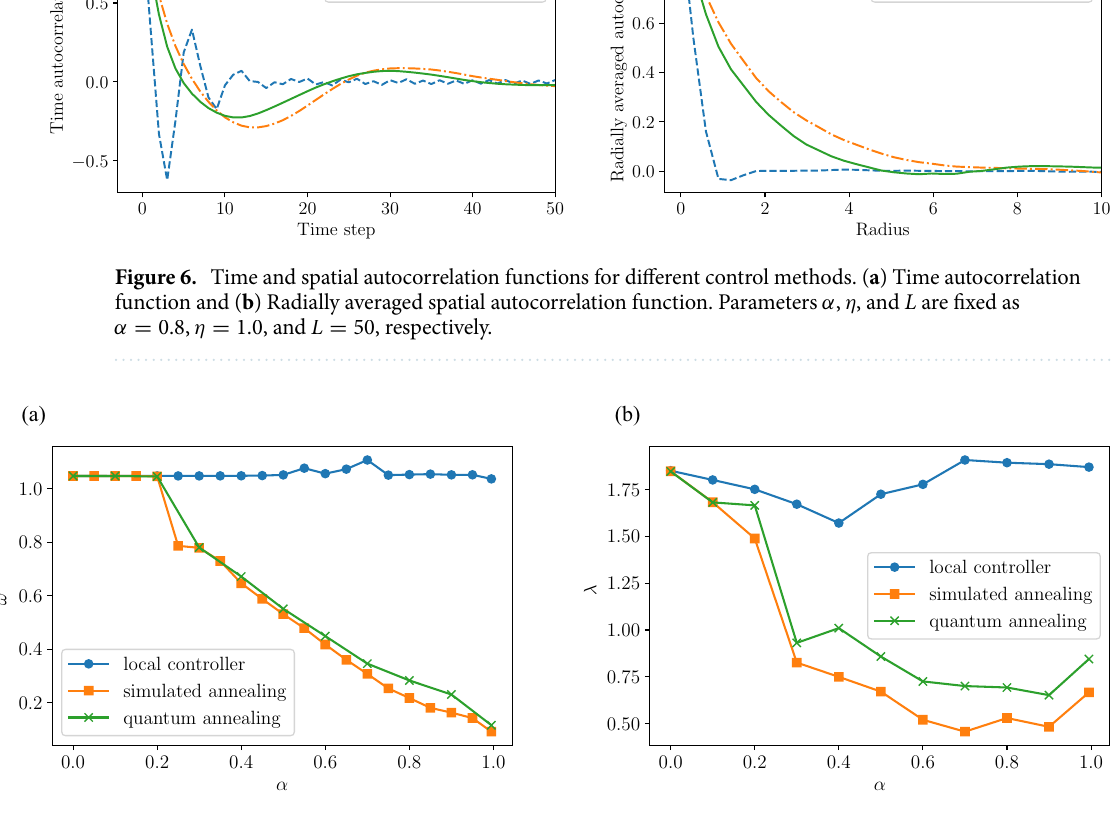
Figure 7. Parameters extracted from time and spatial autocorrelations, as functions of α for different control methods. ( a ) Time autocorrelation function frequency ω versus α and ( b ) Radially averaged autocorrelation decay rate (cid:31) versus α . Parameters η and L are fixed as η = 1.0 and L = 50 ,